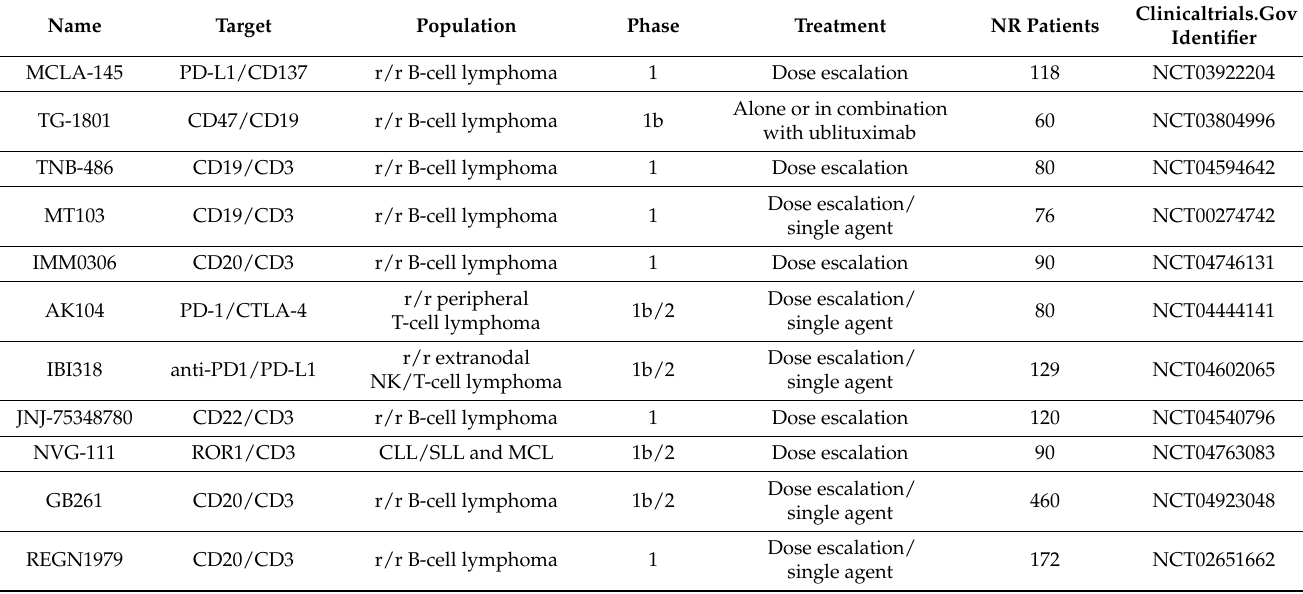
Table 3. Novel bsAbs (ClinicalTrial.gov, accessed on 15 October